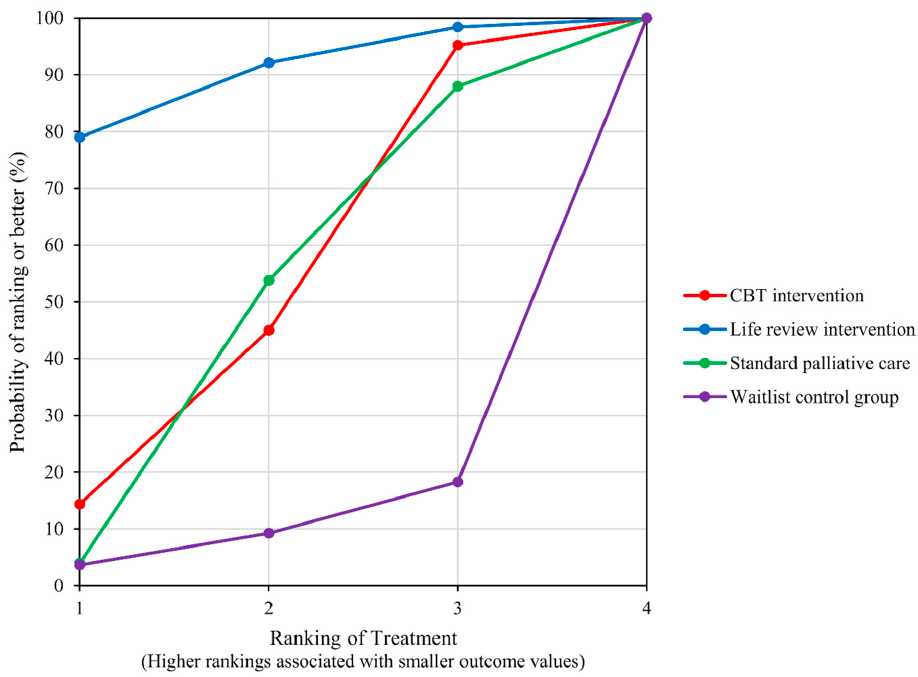
Figure 7. SUCRA plot for outcome of Anxiety.